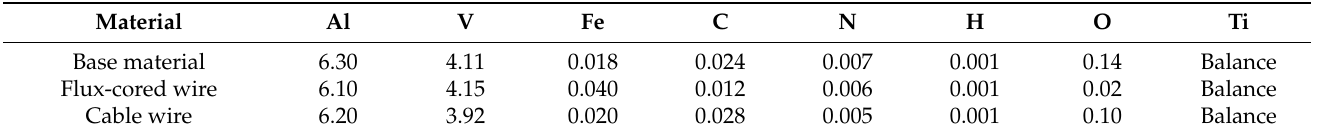
Table 1. Chemical composition of the base metal and filler wires (mass fraction, %).